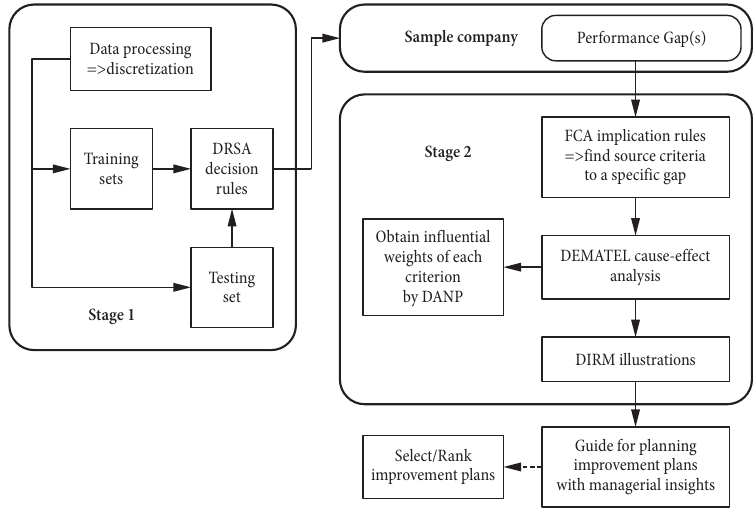
Fig. 1. Two-stage research flows (Guide/Select/Rank FP improvement